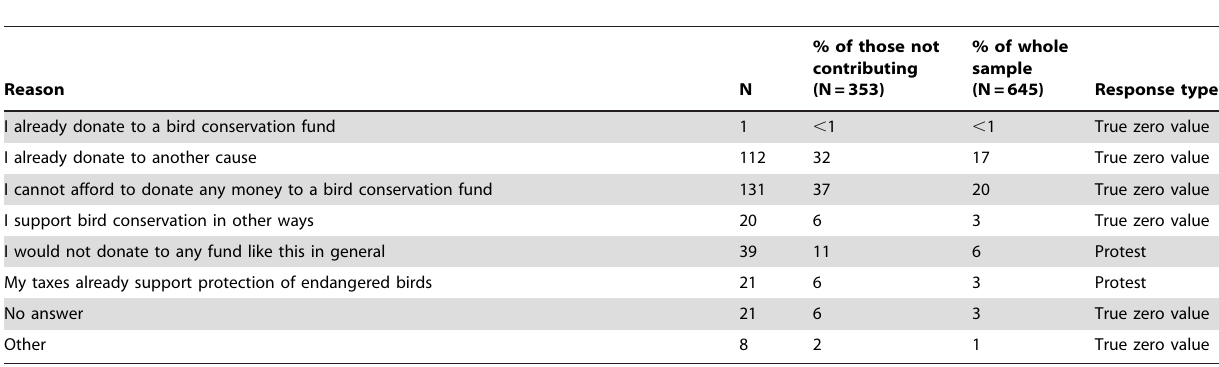
Table 2. Stated reasons for not contributing to a threatened bird conservation fund (in